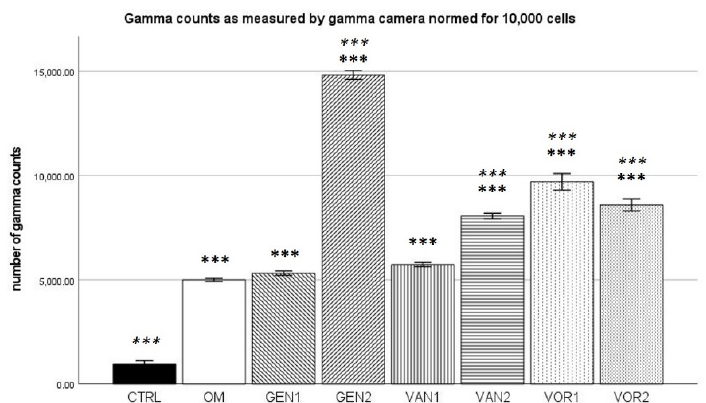
Figure 12. Mean gamma counts per group as measured by the gamma camera. The error bars show the error of mean.